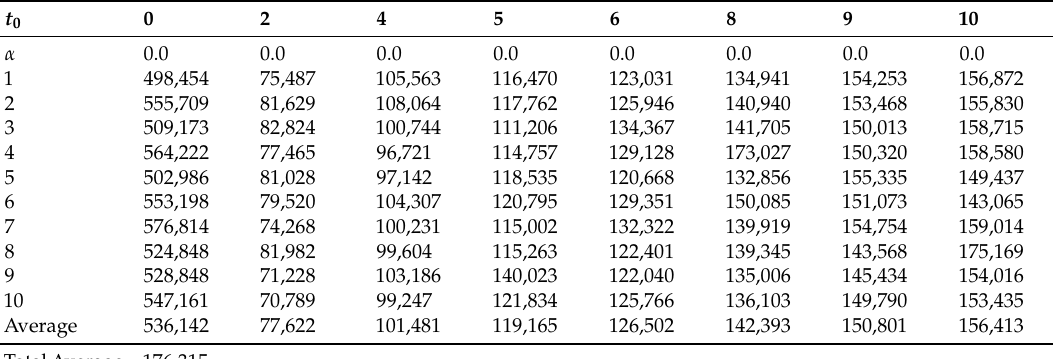
Table 1. Running time for different initial values of Example 1 by our method with test point p = (2.0, 4.0, 2.0).